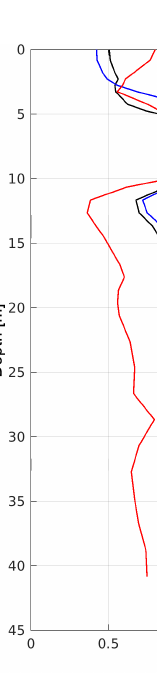
Figure 15. ROMS runs C1, C2, and C3: the rms temperature dif- ferences (cid:49)T between the modelled temperature T ROMS and the ob- served temperature T obs evaluated at the actual depths of the ob- servations. (cid:49)T was computed only for the period after 15 June at